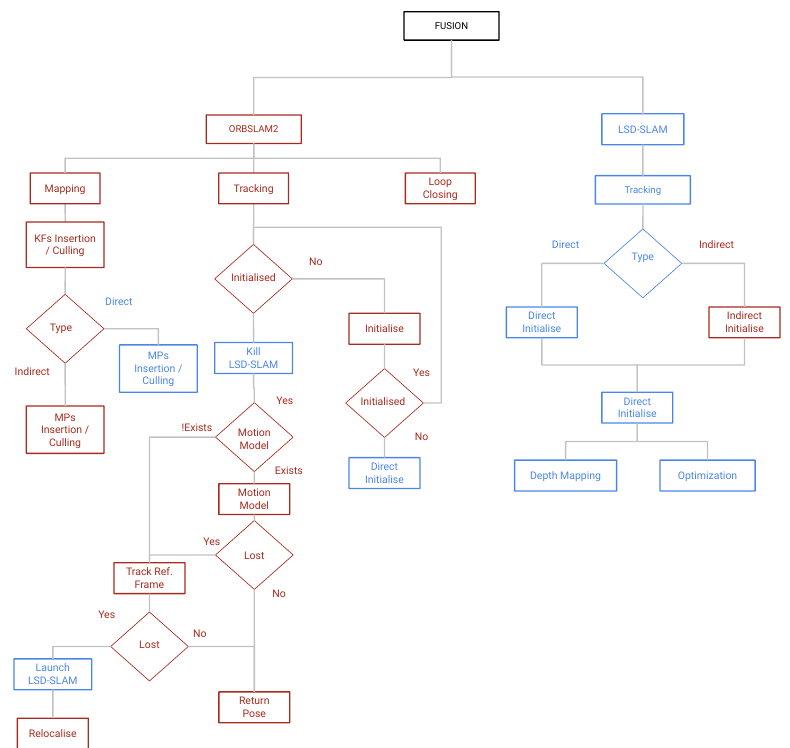
Figure 3. The architecture of the proposed system.“KFs” means keyframes, “MPs” map points and “ref” means reference. Blue modules are direct and red modules are